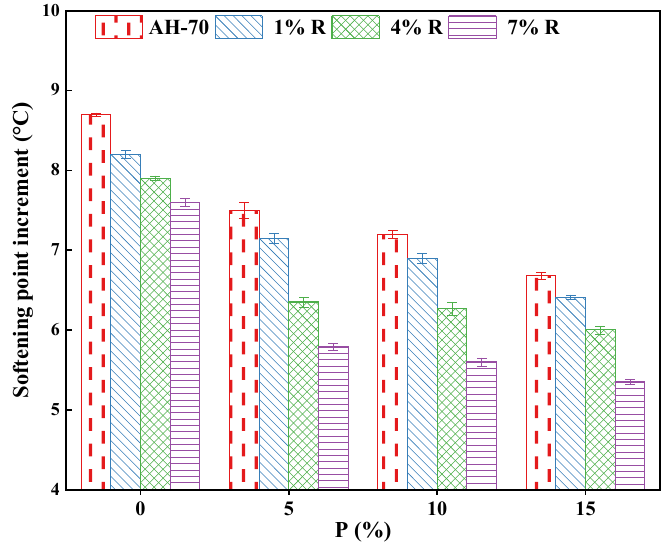
Figure 7. Softening points increment.